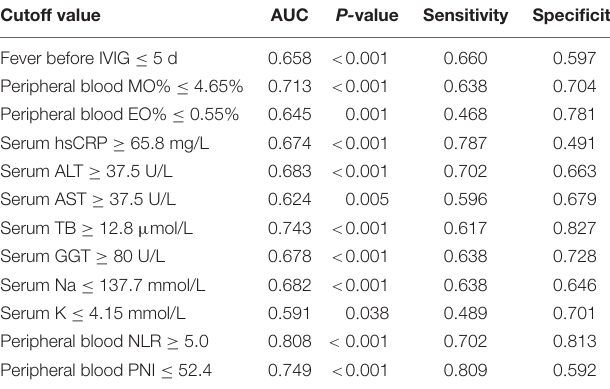
TABLE 3 | The cutoff value of converting continuous variables to dichotomous variables in training set.